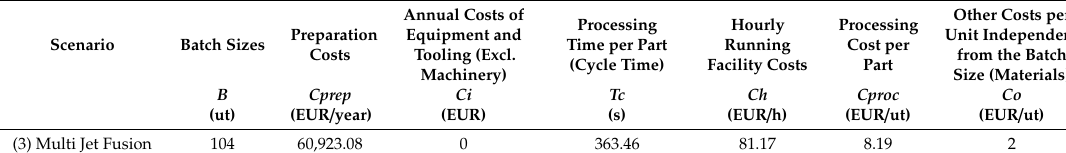
Table 8. Main parameters for the unit cost and production times comparison for the scenario based on the direct manufacturing of the swimming pool sink cage ribs via multi jet